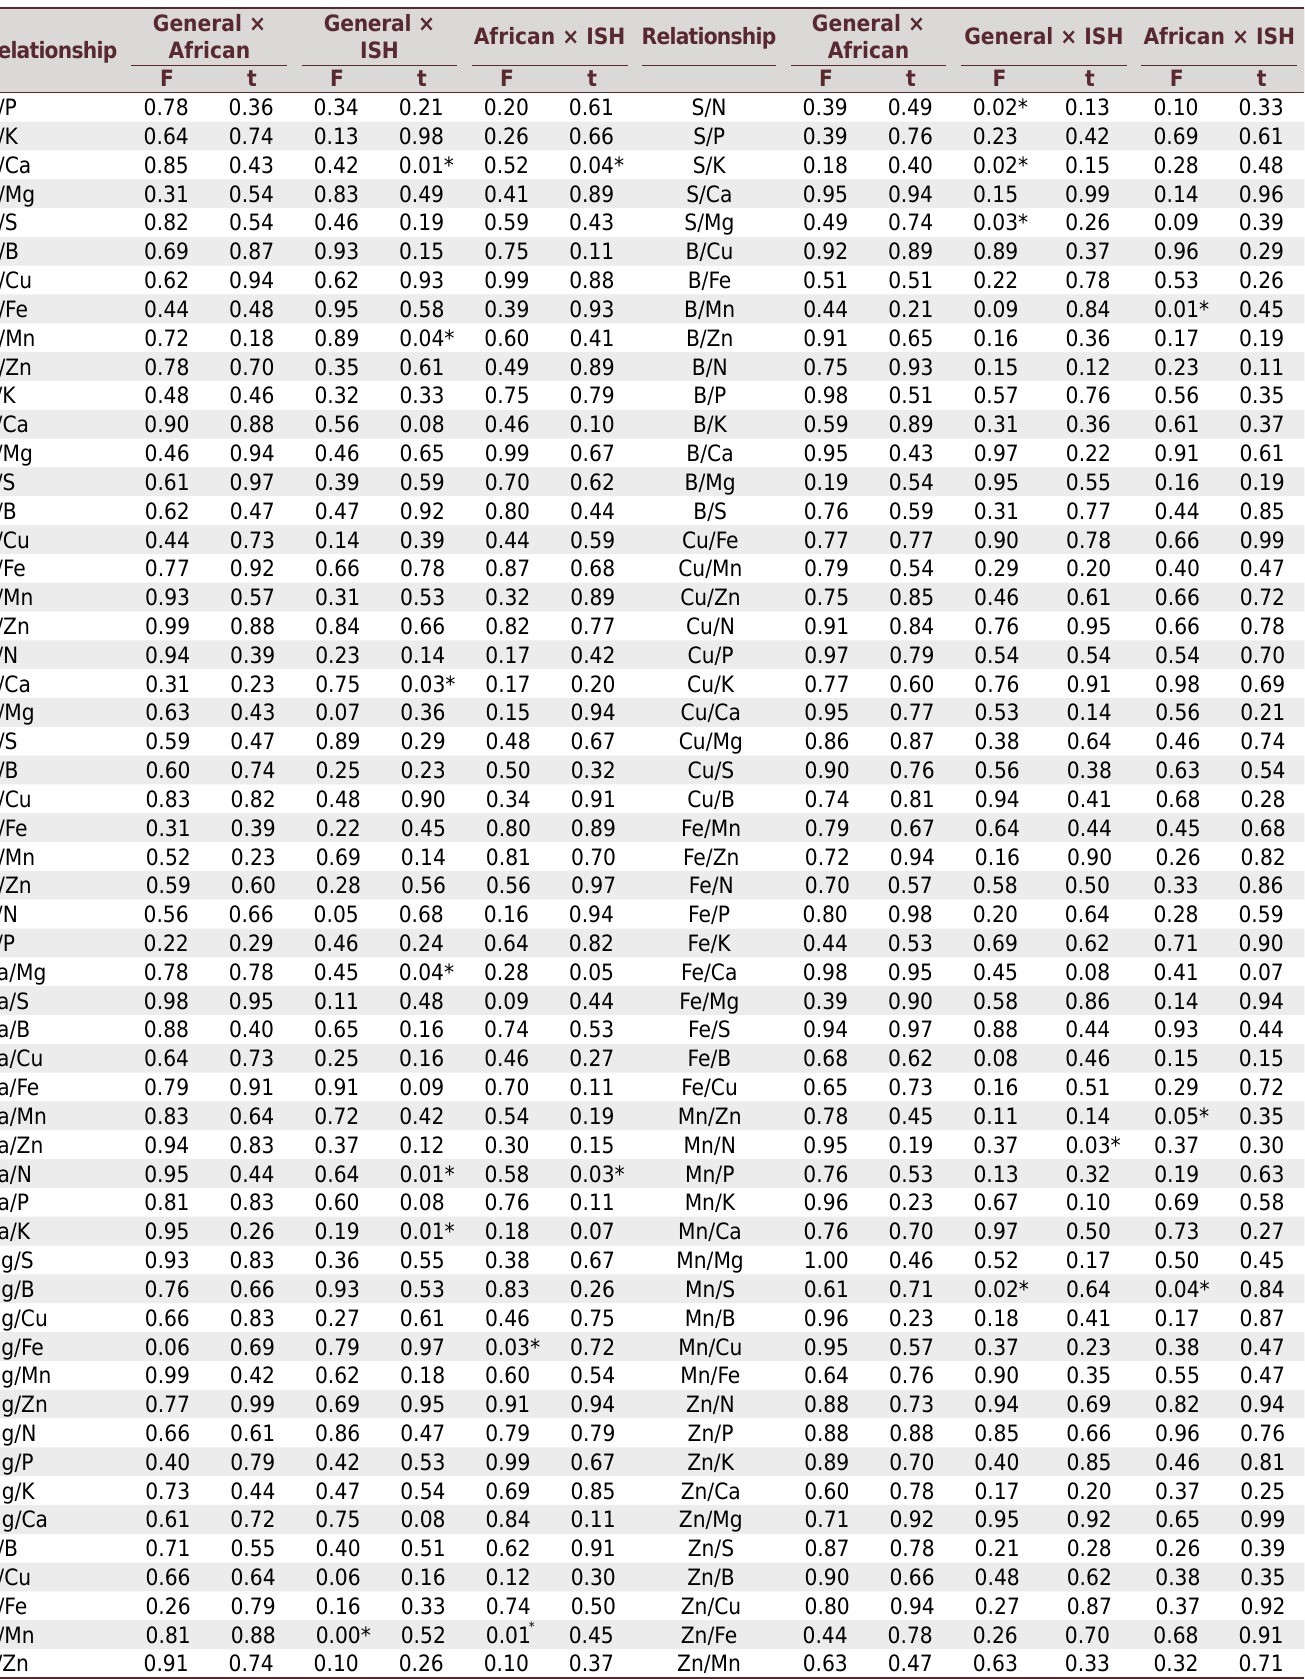
Table 4. Probability values (p-value) obtained from the F and Student’s t test for comparison of relationships calculated in a general reference population (indiscriminately for genetic material and ages) and for specific reference populations with African type oil palm and interspecific hybrids (ISH) General Relationship